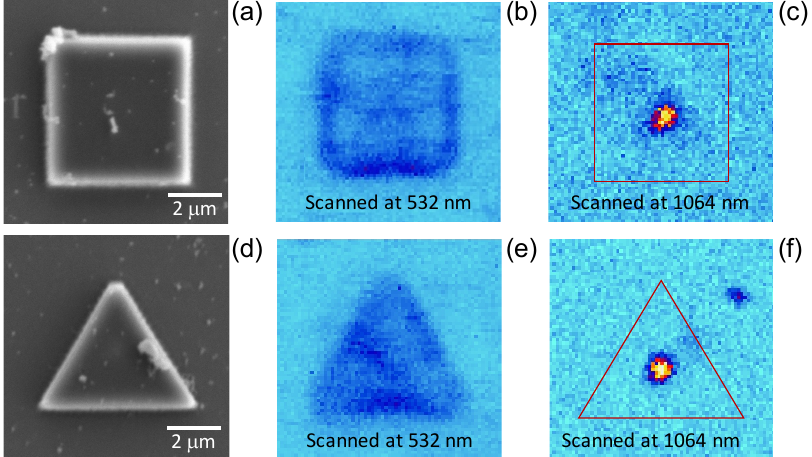
Figure 3. ( a ) SEM image of a square structure containing a KTP NP at the center. Fluorescence image ( b ) and SHG image ( c ) of the corresponding structure, obtained by scanning with 532 nm laser and 1064 nm laser, respectively. The SHG image shows clearly that the polymeric square structure contains a KTP NP at the center. ( d – f ): similar SEM, fluorescence et SHG images of a triangular structure containing a KTP